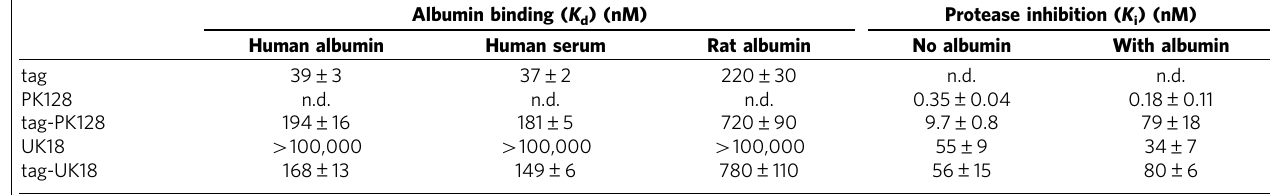
n.d., not determined. Bindingtoalbuminwasmeasuredbyfluorescencepolarization.Forserumassays,ahumanalbuminconcentrationof0.6mMwasusedtocalculatethe K d .Inhibitionconstantsweremeasuredinprotease activity assays using fluorogenic substrates. K i values indicated for PK128 and tag-PK128 refer to plasma kallikrein inhibition and K i s for UK18 and tag-UK18 to urokinase inhibition. Inhibition in the presence of albumin was measured using 25 m M human albumin. All measurements were done in triplicate and s.d.’s are indicated.